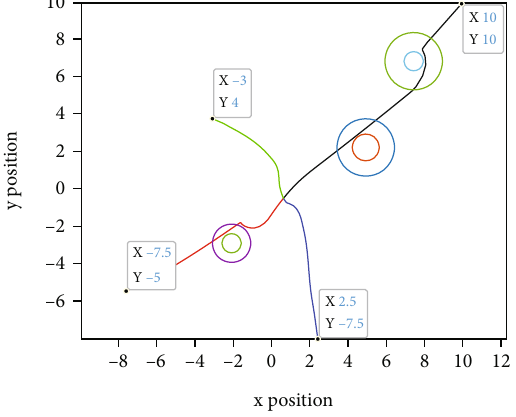
Figure 7: Simulation of formation obstacle